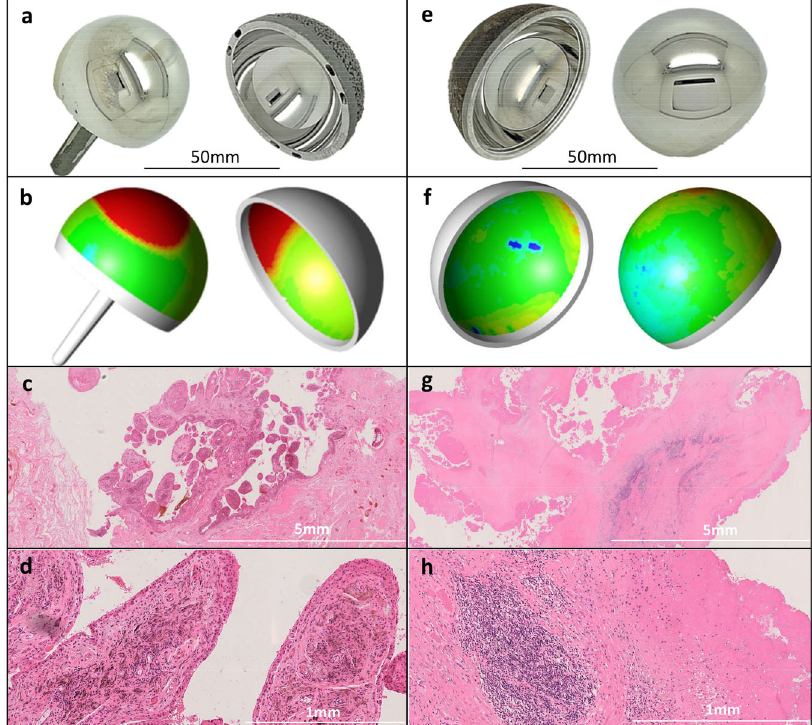
Fig. 1 Explant analysis and tissue responses. MoM hip components are manufactured from standard, medical-grade CoCr alloy (ASTM-75 or ASTM- 1537), which is composed of approximately 65% Co and 30% Cr by weight. Explanted prostheses can be reverse engineered using coordinate measuring machines (CMMs) to quantify the volumetric material loss through wear and corrosion (shown in red in the wear maps below). Serum or whole blood Co and Cr concentrations provide a reliable in-vivo surrogate measure of the rate of this material loss 80 . Panels a,b,c and d relate to the same patient, whose blood Co concentration was elevated at 20.1 µ g/l just prior to revision. a The explanted 46 mm diameter Birmingham Hip Resurfacing. b The corresponding CMM generated wear map (volumetric wear rate of 25mm 3 /year). c and d The synovial tissue sections (hematoxylin and eosin (H&E) stained), (X2 magni fi cation and x15 magni fi cation respectively) showing heavy macrophage in fi ltration, no lymphocytes. Panels e – h relate to a second patient, whose blood Co concentration was 1.5 µ g/l just prior to removal of her ASR XL THR. e The explanted 45 mm diameter prosthesis. f The corresponding